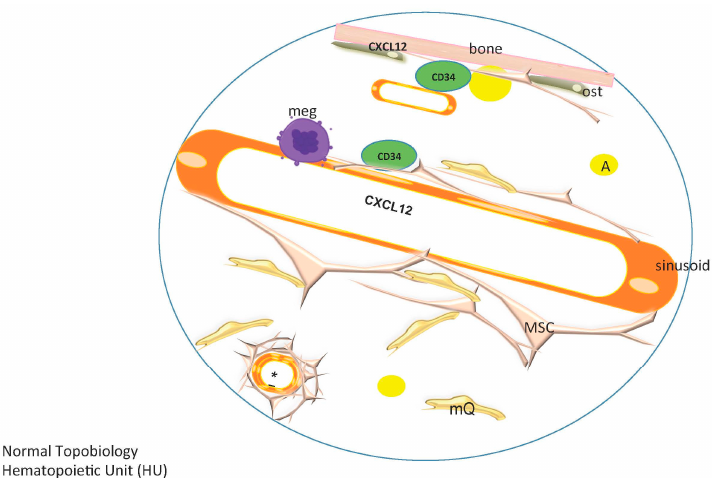
Figure 8. Topobiology of a normal Hematopoietic Unit (HU) in humans. In a normal HU, mesenchymal stromal/stem cells (MSCs) are located in paratrabecular and perivascular areas, and to a lesser extent in the parenchyma. Osteoblast number decreases with age. Megakaryocytes (meg) are located adjacent to sinusoids, MSCs form an outside layer on the sinusoids. Arterioles and capillaries are covered sequentially by pericytes/vascular smooth muscle and a full and thick layer of MSCs, and are often rimmed by plasma cells. Macrophages (mQs) are as abundant as MSCs, and are scattered throughout the bone marrow in perivascular, paratrabecular and parenchymal areas. CD34+ hematopoietic progenitor/stem cells (HPSCs) are located in perivascular areas, with fewer at paratrabecular regions. CXCL12 is produced predominantly by endothelial cells and by osteoblasts.